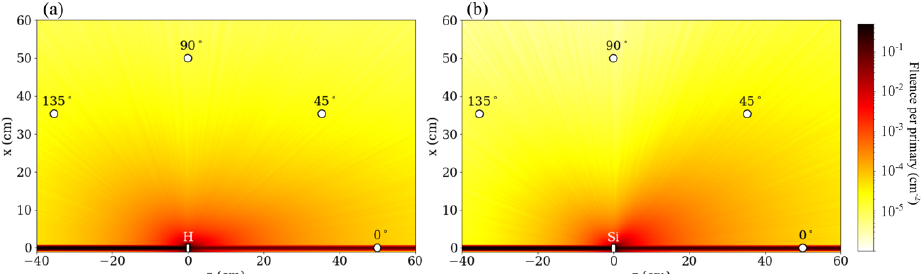
Fig. 1. Total neutron fluence over the simulated geometry for a broad spectrum neutron beam along the z-axis, incident on targets comprised of (a) hydrogen and (b) silicon respectively. Detector regions are indicated with the white